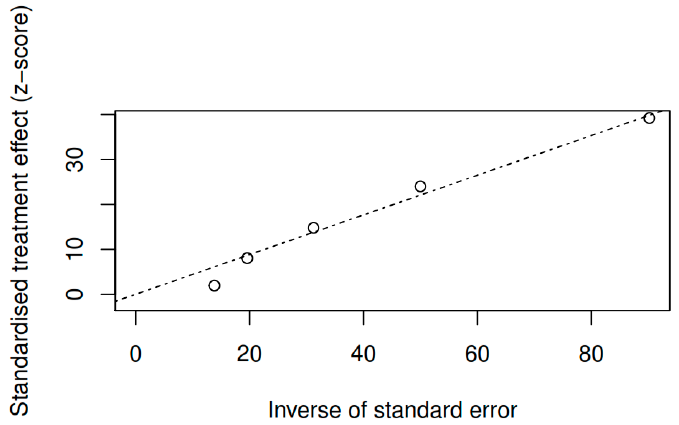
Figure 14. Radial adjustment chart of the random effects model for the variable negative symptoms (pretest–posttest).